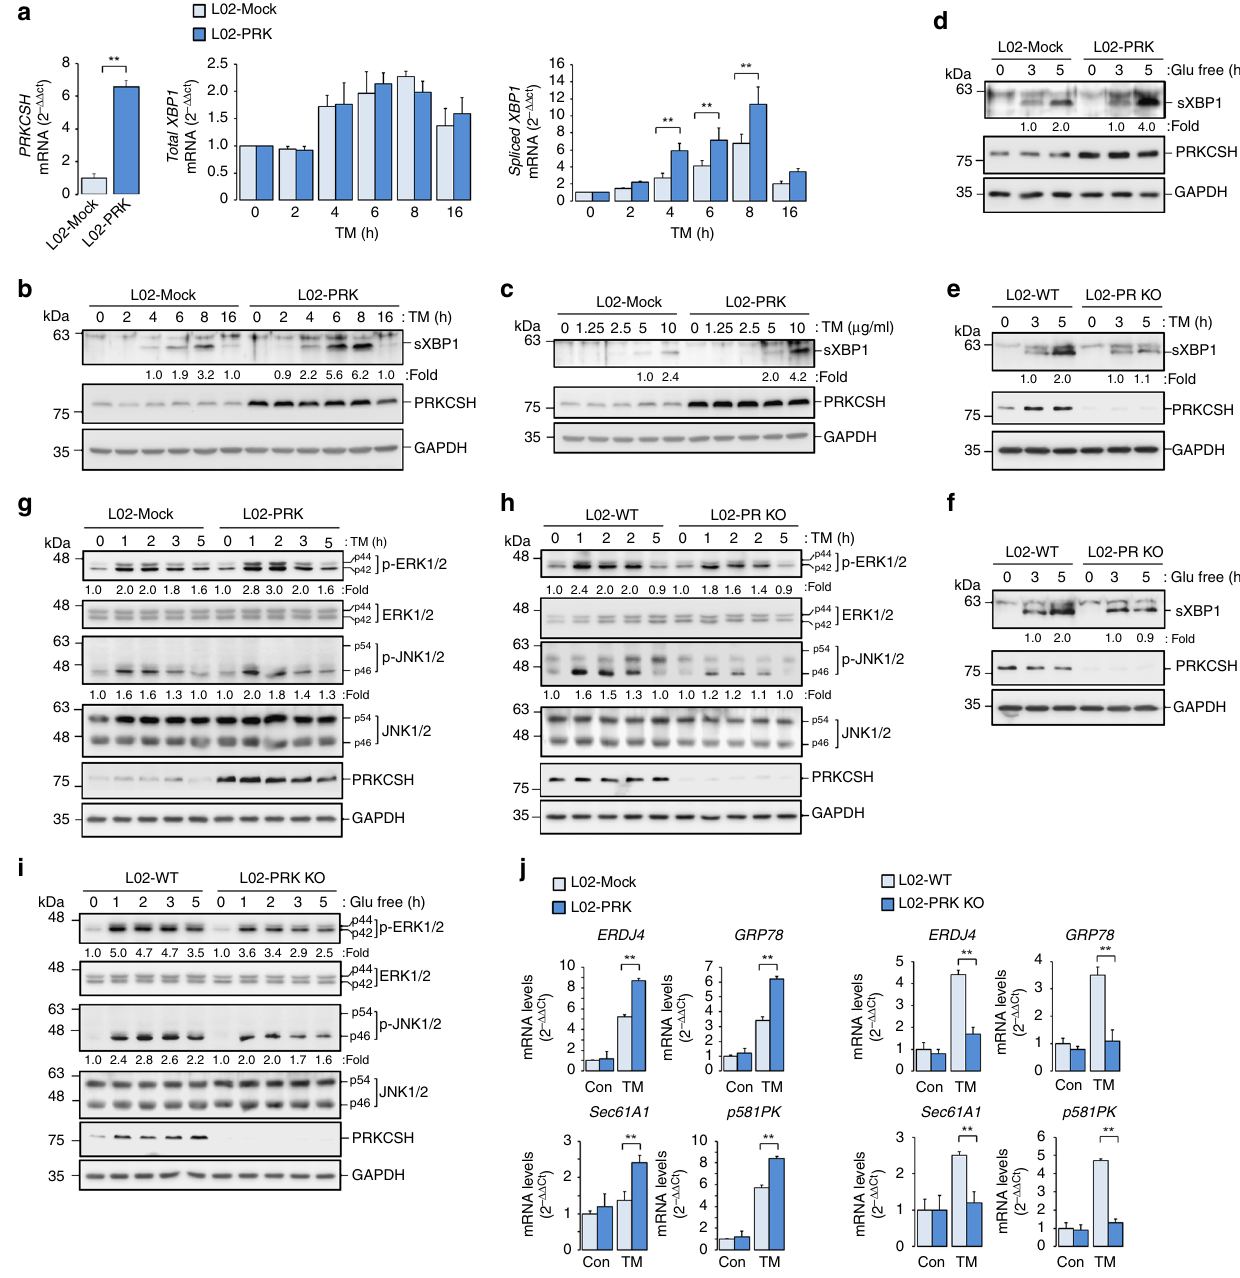
Fig. 2 PRKCSH promotes activation of the IRE1 α pathway under ER stress. a Quantitative real-time PCR analysis of total XBP1 and spliced XBP1 mRNA levels in L02-Mock and L02-PRK cells treated with 10 μ g/mL TM for the indicated time. b , c Immunoblot analysis of spliced XBP1 protein (sXBP1) levels in L02- Mock and L02-PRK cells treated with 10 μ g/mL TM for the indicated time ( b ) or the indicated doses of TM for 5 h ( c ). d Immunoblot analysis of sXBP1 levels in L02-Mock and L02-PRK cells treated with glucose-free medium for the indicated time. e , f Immunoblot analysis of sXBP1 levels in L02-WT and L02-PRK KO cells treated with 10 μ g/mL TM ( e ) or glucose-free medium ( f ) for the indicated time. g Immunoblot analysis of ERK and JNK phosphorylation in L02-Mock and L02-PRK cells treated with 10 μ g/mL TM for the indicated time. h , i Immunoblot analysis of ERK and JNK phosphorylation in L02-WT and L02-PRK KO cells treated with 10 μ g/mL TM ( h ) or glucose-free medium ( i ) for the indicated time. j Quantitative real-time PCR analysis of UPR genes in L02-Mock and L02-PRK cells, or L02-WT and L02-PRK KO cells treated with 10 μ g/mL TM for 5 h. sXBP1, phosphorylated ERK, and phosphorylated JNK levels shown below the blots were normalized to GAPDH, total ERKs, and total JNKs, respectively. For quantitative real-time PCR analysis, Data are representedas mean ± SEM of four samples. One-way ANOVA; ** P <